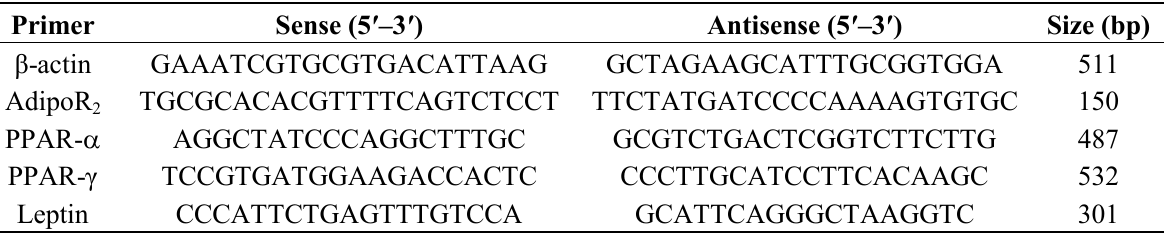
Table 1. Sequences of